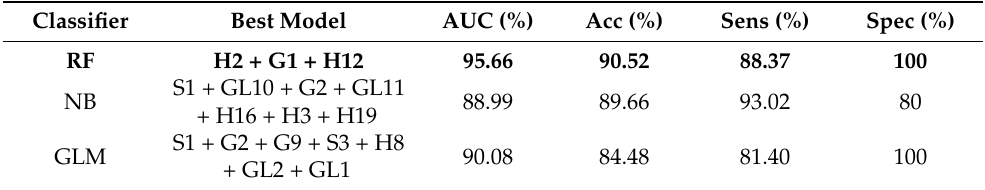
Table 3. Classification performance of the best models obtained from the complete set of PCs calculated on 100 ten-fold cross-validation rounds. The best result is highlighted in